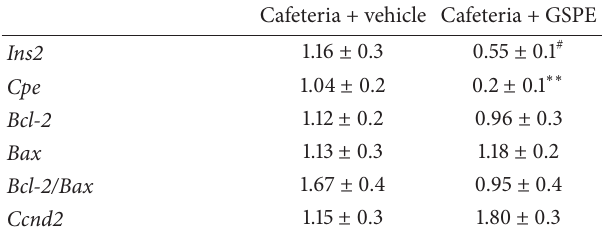
Table 3: Effects of GSPE treatment of cafeteria-fed rats on gene expression in the pancreas. ∗∗ 𝑃 ≤ 0.01 and # 𝑃 ≤ 0.1 versus vehicle- treated